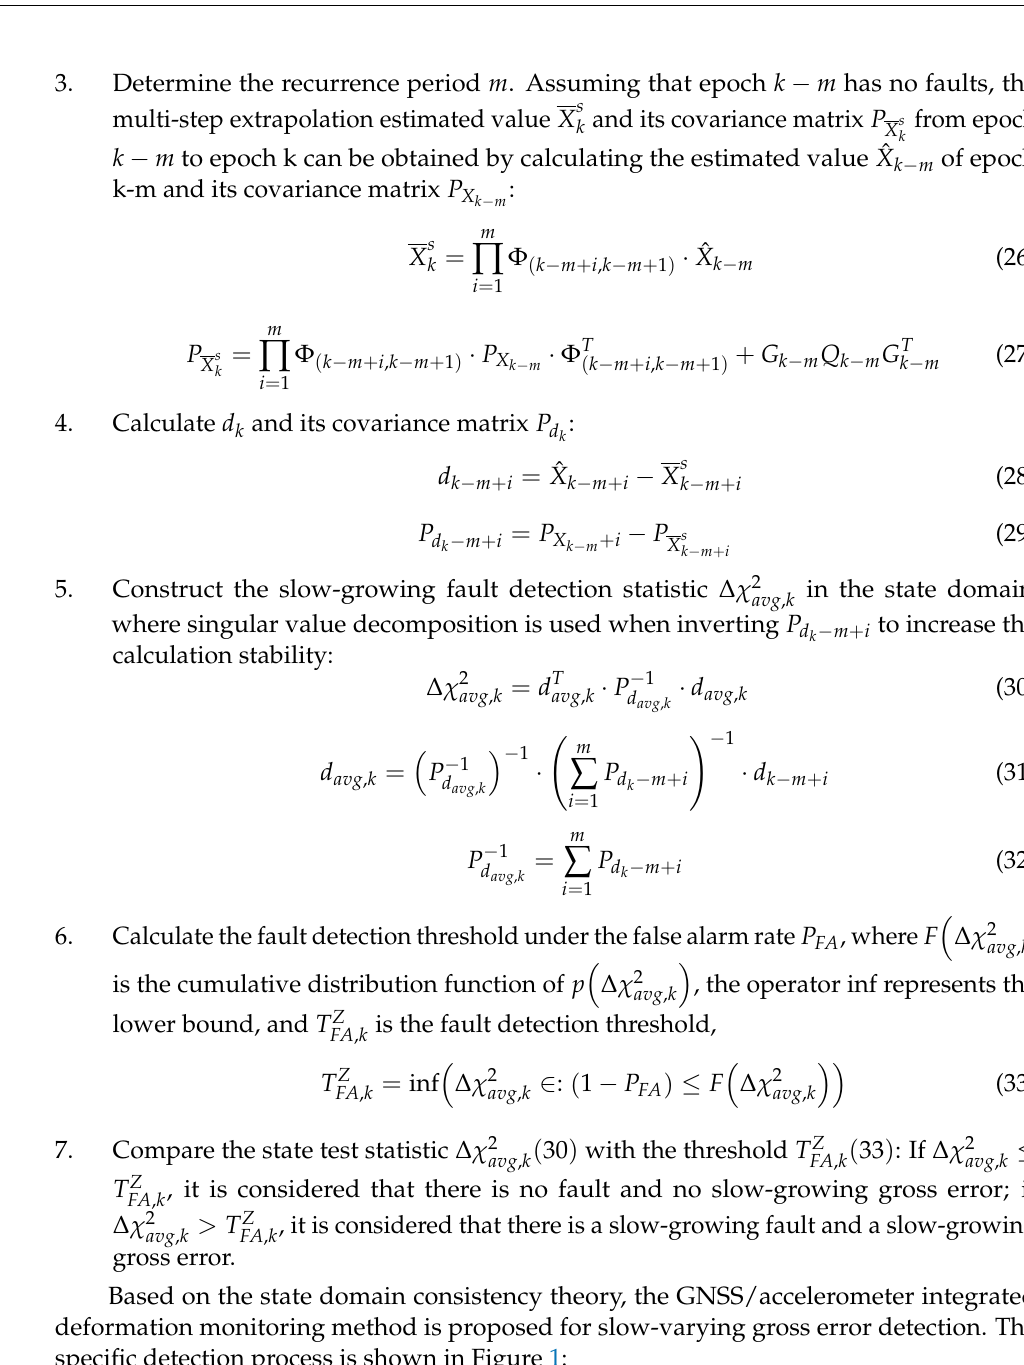
3. Determine the recurrence period m . Assuming that epoch k − m has no faults, the multi-step extrapolation estimated value X k − m to epoch k can be obtained by calculating the estimated value ˆ X k − m of epoch k-m and its covariance matrix P X